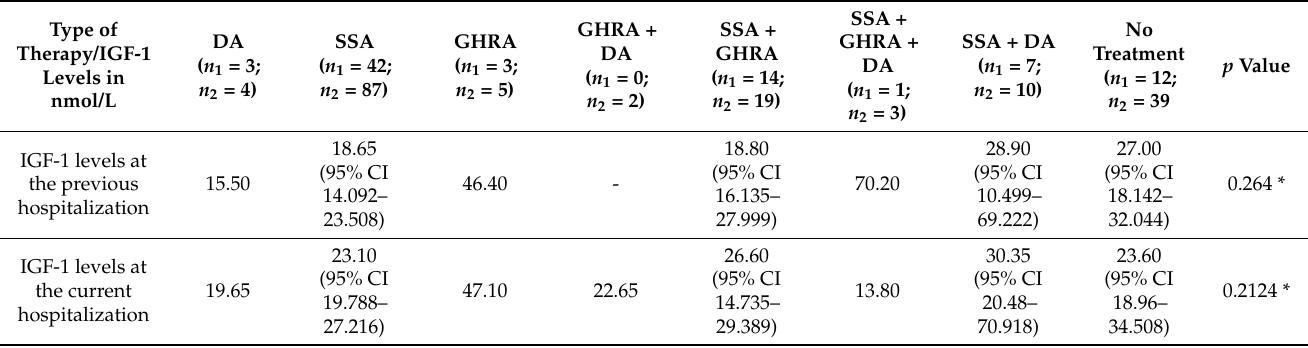
Table 3. IGF-1 levels and type of therapy by mechanism of action.